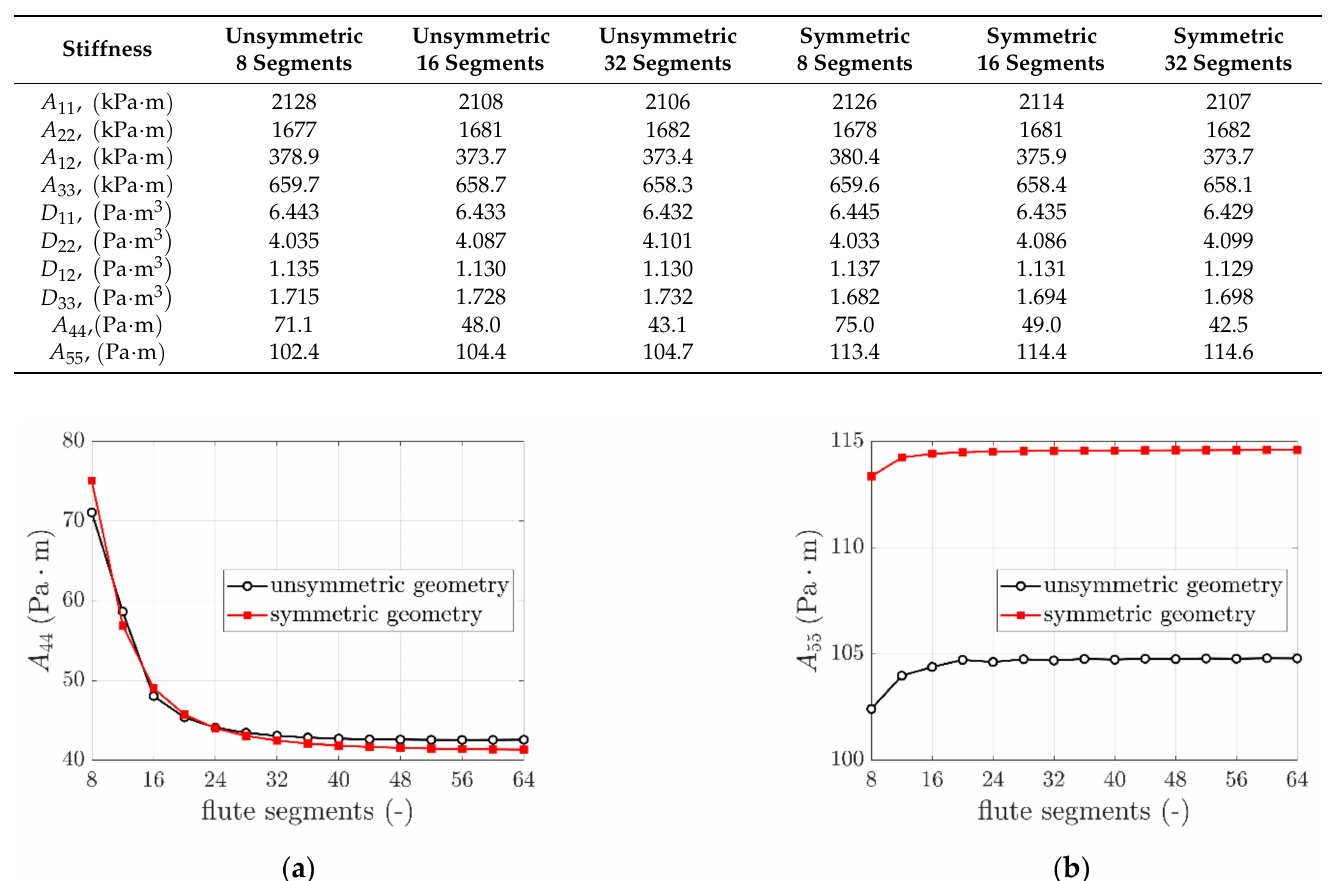
Table 4. The stiffnesses of the representative shell element computed for different number of segments for one fluting period–sine geometry.